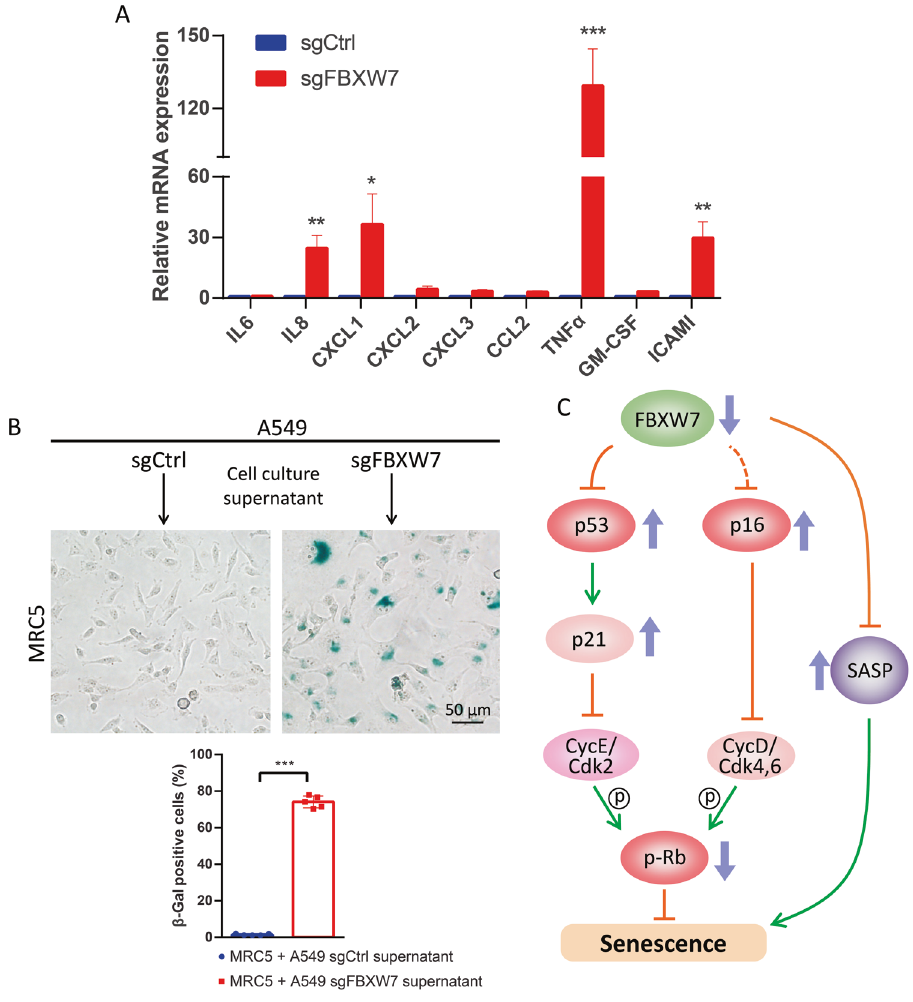
Fig. 5 FBXW7 loss induces the senescence-associated secretory phenotype (SASP). A A549 cells, with or without FBXW7 deletion, were harvested for qRT-PCR analysis for the indicated SASP factors. Data are presented as the mean ± SEM from three independent experiments. n = 3; * p < 0.05; ** p < 0.01; *** p < 0.001. B The conditional medium from A549 cells, with or without FBXW7 deletion, was used to culture MRC5 cells for 2 weeks, followed by SA- β -Gal staining (top). The percentage of SA- β -Gal-positive cells in the total number of cells was determined (bottom). Scale bar represents 50 μ m. Data are presented as the mean ± SD. *** p < 0.001. C A model for FBXW7 inactivation-induced